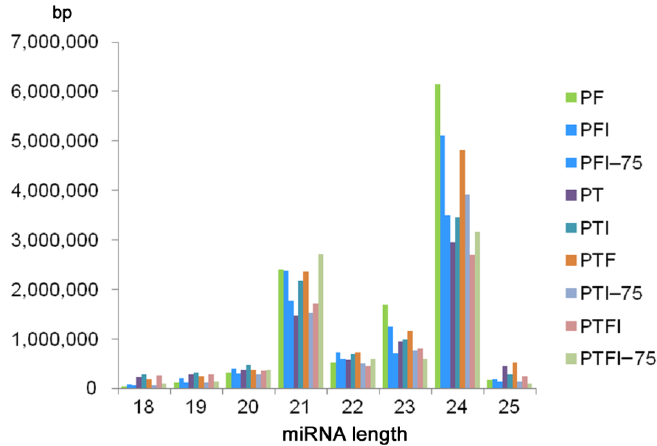
Figure 2. The length distribution of miRNAs generated in nine samples.